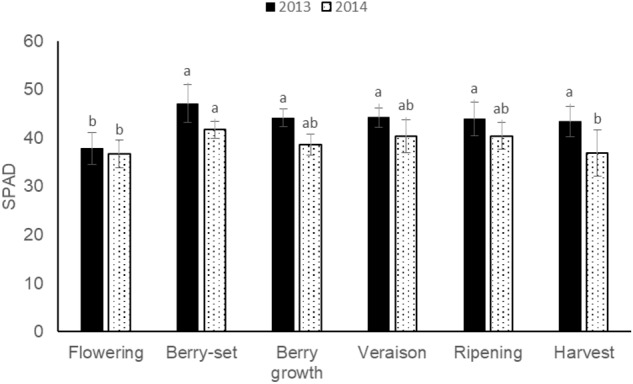
SPAD values of leaf opposite to the cluster of Italia table grape throughout the seasons of 2013 and 2014 as a function of the different phenological growth stages. Bars represent standard deviation. For each season, data points followed by a different letter are significantly different at P ≤ 0.05 according to REGQW test.